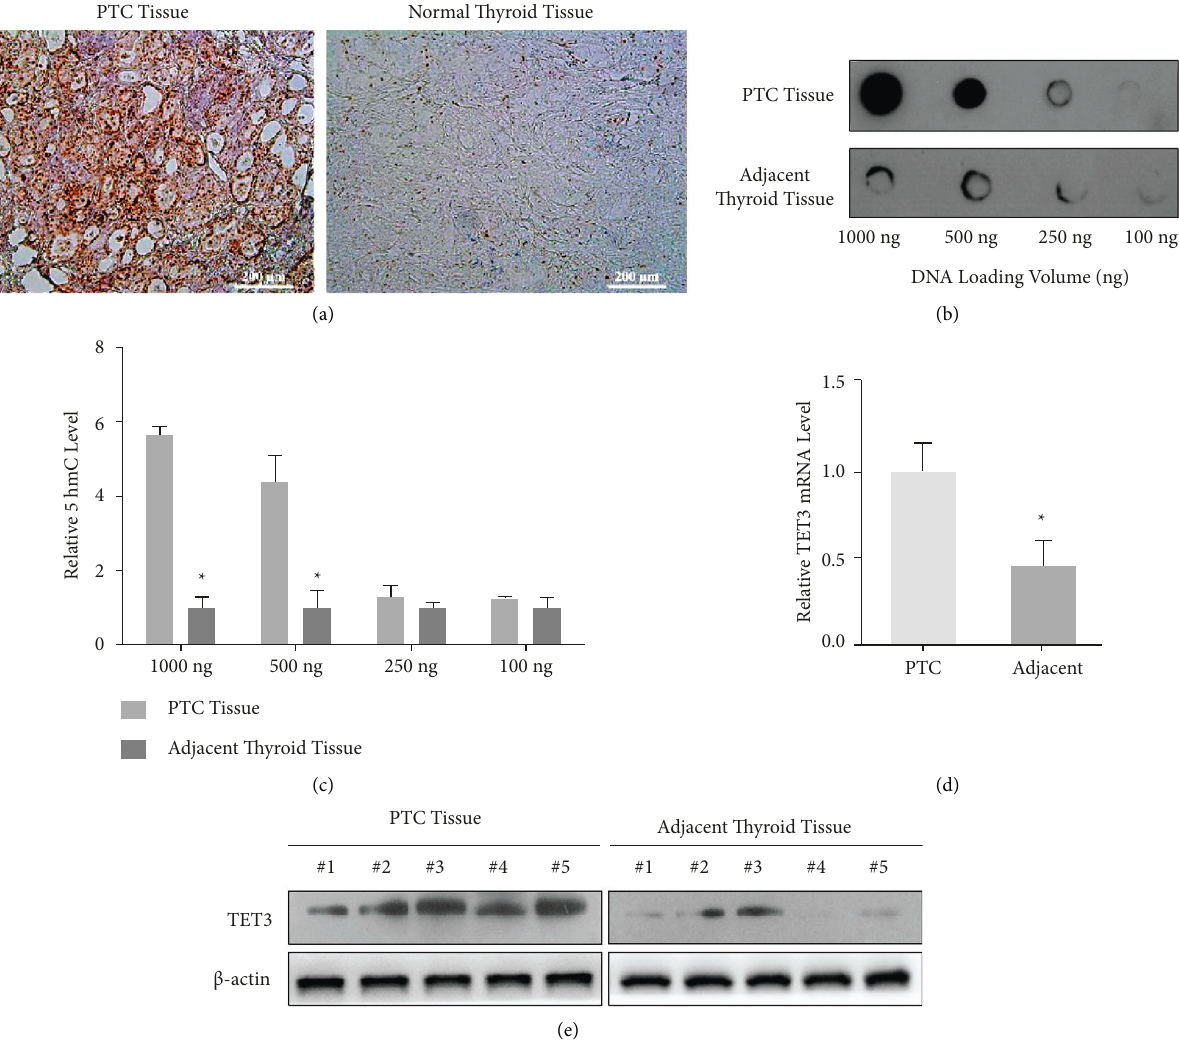
Figure 1: (a) The results of hydroxymethylation 5hmC staining in clinical specimens of papillary thyroid carcinoma showed that 5hmC was expressed in papillary thyroid carcinoma and normal thyroid tissues adjacent to the cancer, and the positive expression was brown (scale bar � 200 μ m); (b) the results of genomic DNA 5hmC dot blot hybridization (dot blot) of papillary thyroid carcinoma;. (c) statistical analysis of genomic DNA 5hmC dot blot hybridization (dot blot) in papillary thyroid carcinoma; (d) real-time PCR was used to detect the expression of TET3 mRNA in papillary thyroid carcinoma and normal thyroid tissues; (e) western blot was used to detect the expression of TET3 in